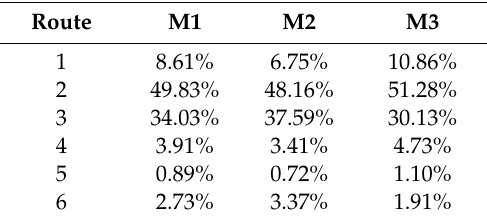
Table 4. Choice probabilities of each route.